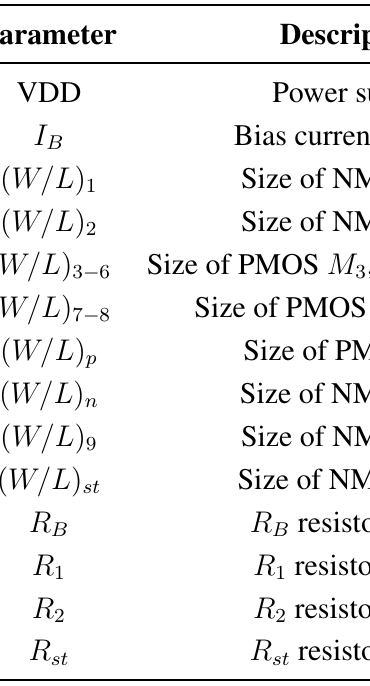
Table 1. Voltage references bias setting and devices